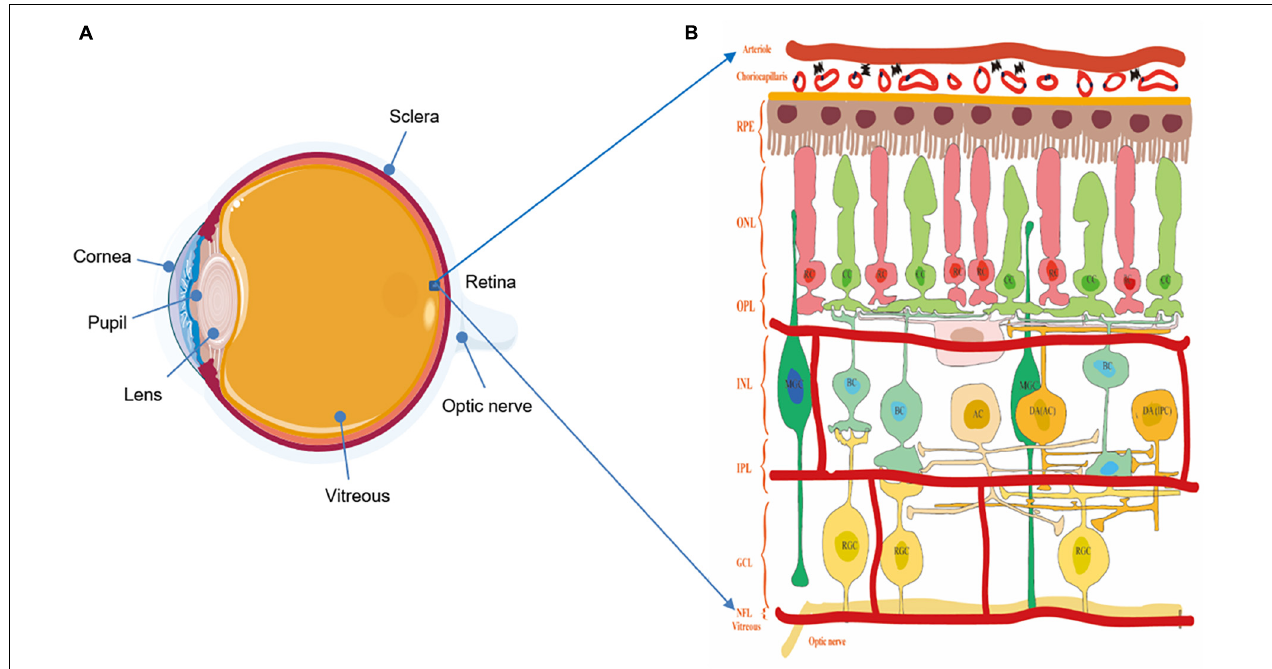
FIGURE 1 | (A) The structure of the eyeball. (B) The structure of the retina and diagram of the retinal neurons. Notably, understanding the physiologic structure and function is critical for better exploring the relationship of visual function and morphological changes. The retina possesses complex and multilayer structures and a large number of cells with microcircuits features and different functions. ILM, inner limiting membrane; RNFL, retina nerve fibers layer; GCL, ganglion cell layer; IPL, inner plexiform layer; INL, inner nuclear layer; OPL, outer plexiform layer; ONL, outer nuclear layer; ORL, outer retina layer; RPE, retinal pigmented epithelium; RC, rod cell; CC, cone cell; BC, bipolar cell; HC, horizontal cell; AC, amacrine cell; DA AC dopaminergic amacrine cell; DA IPC, dopaminergic interplexiform cell; RGC, retinal ganglion